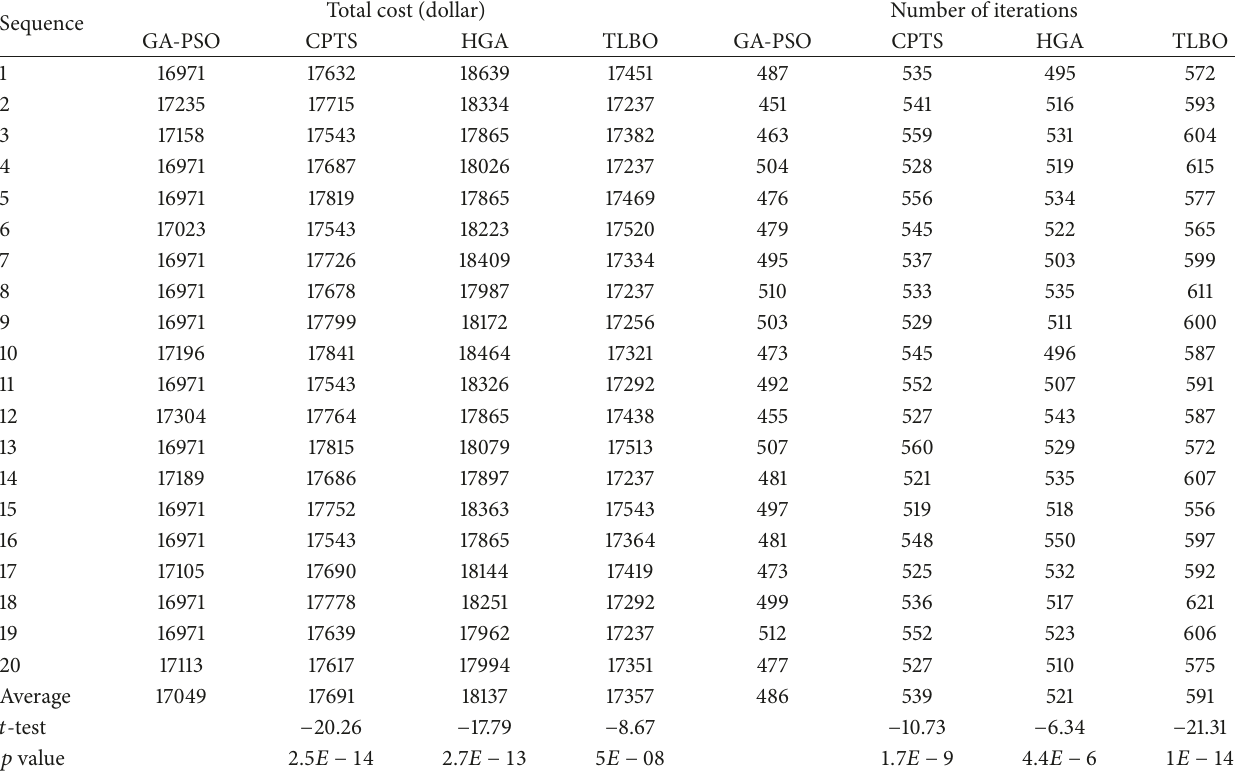
Table 6: Algorithms optimization results